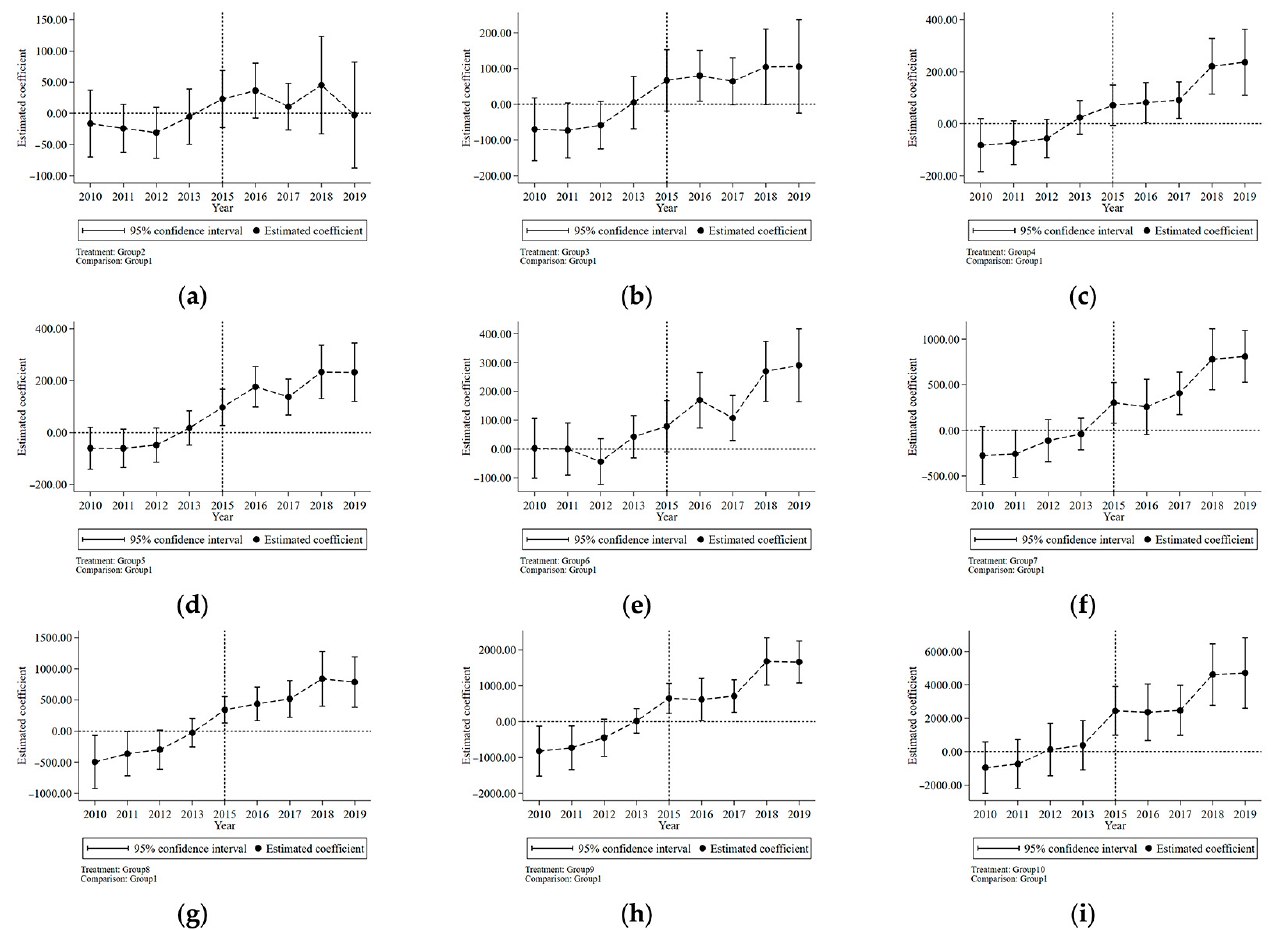
Figure 4. Parallel trend test for Model II. ( a ) Parallel trend test between cities in Group1 and Group 2; ( b ) Parallel trend test between cities in Group1 and Group 3; ( c ) Parallel trend test between cities in Group1 and Group 4; ( d ) Parallel trend test between cities in Group1 and Group 5; ( e ) Parallel trend test between cities in Group1 and Group 6; ( f ) Parallel trend test between cities in Group1 and Group 7; ( g ) Parallel trend test between cities in Group1 and Group 8; ( h ) Parallel trend test between cities in Group1 and Group 9; ( i ) Parallel trend test between cities in Group1 and Group 10.